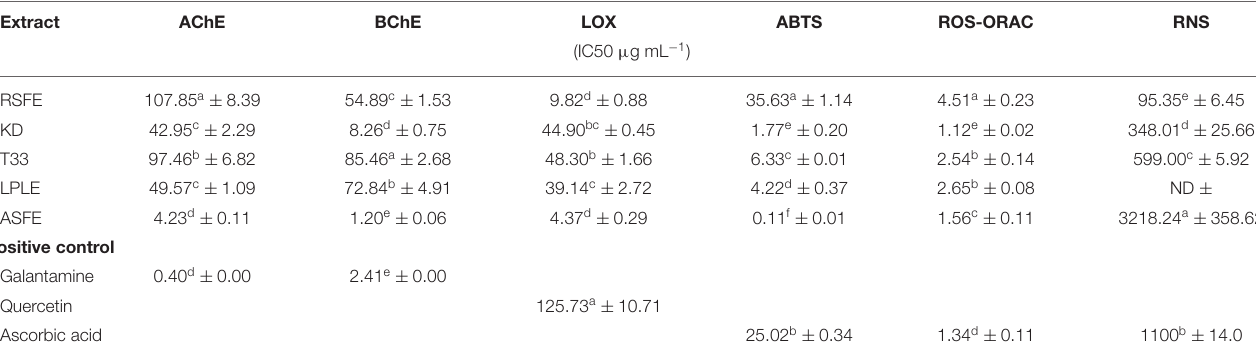
TABLE 6 | IC 50 values from in vitro assays of different extracts using anticholinesterase (AChE and BChE), anti-inflammatory (LOX), and antioxidant (ABTS, ROS, and RNS) assays.